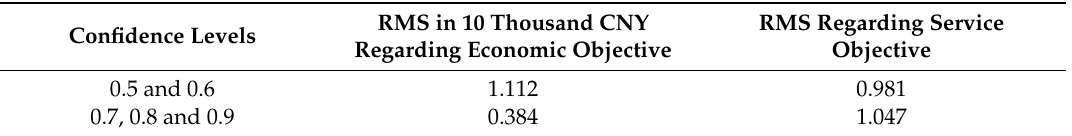
Table 3. Objective gaps between the planned best routes provided by MILP model I and the actual best